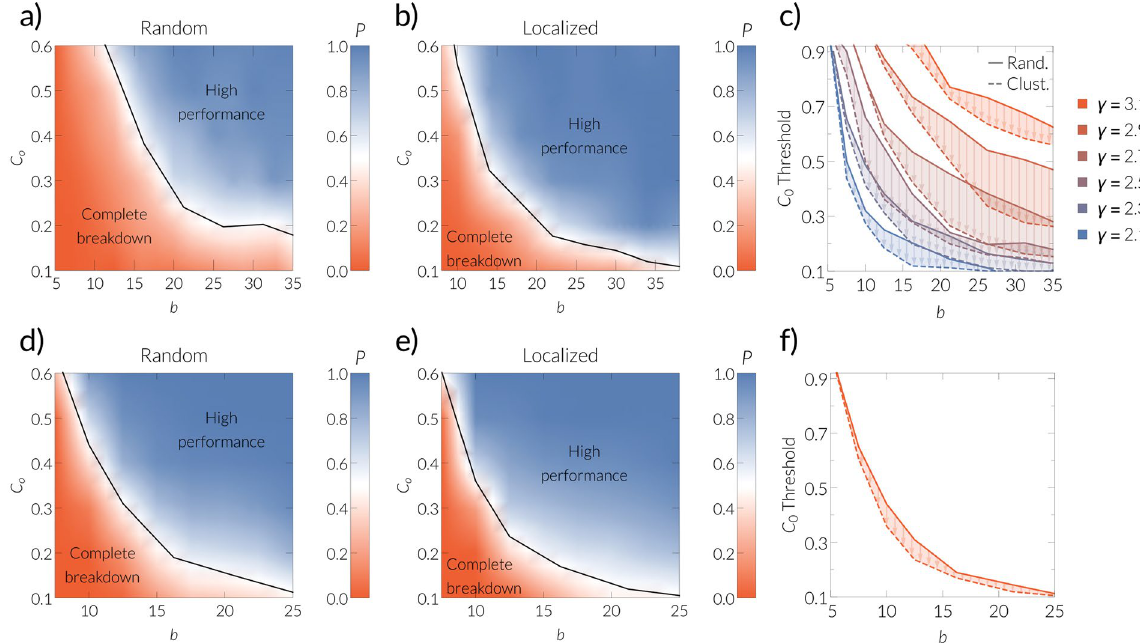
Figure 2. ( a ) Probability of reaching the successful state (blue color) as a function of the initial cooperation rate C 0 and the payoff b . Here, we generated networks using the model described in Appendix with 10000 nodes, a power law degree distribution with exponent γ = 2.5, temperature T = 0.4, and mean degree < k > ≈ 6. The results are averaged over 50 simulations. A realization is said to have approached the functional state if the performance of the system in the stationary state is larger than 0.5. To compute the quantities in the stationary state, we first let 250 rounds pass, which avoids the initial transient phase, and then we average over another 250 rounds (we observe that this initial phase usually takes approx. 25 steps, and therefore allow 10 × 25 steps to pass, which indeed ensures that the system is in one of the two described states). Note that we only observe states that either perform very well with success rates .  0 5 or very poorly with success rates .  0 5 (see Supplementary Materials). Initial conditions are randomly assigned cooperators. (b) Same as before but starting from clustered cooperators according to Eq. (3). ( c ) Threshold value of C 0 for the system to approach the functional state with at least 50% probability (black lines in a, b ) for different values of the power-law exponent γ . Solid lines correspond to the random distribution of initial cooperators, whereas dashed lines represent the clustered initial configuration. Arrows show the reduction of the initial “critical mass”. The network parameters are the same as in ( a ). (d,e) Same as a–c but for the IPv6 Internet network (averaged over 200 realizations). (f) The same as in ( c ) but for the IPv6 Internet topology. The solid line corresponds to the black line in ( d ) and the dashed line is the same as the black line in ( e ). Arrows show the reduction of the initial “critical mass” due to localization of the initial